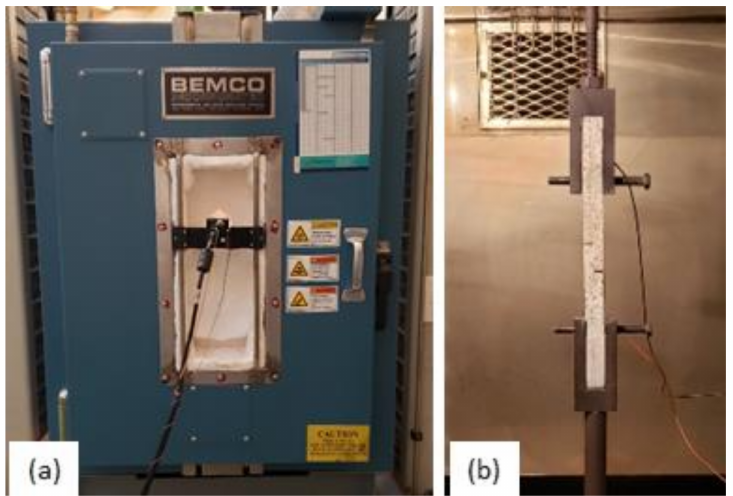
Figure 3. Test setup ( a ) BEMCO environmental chamber installed within the test frame. ( b ) Lap shear test specimen installed with BEMCO